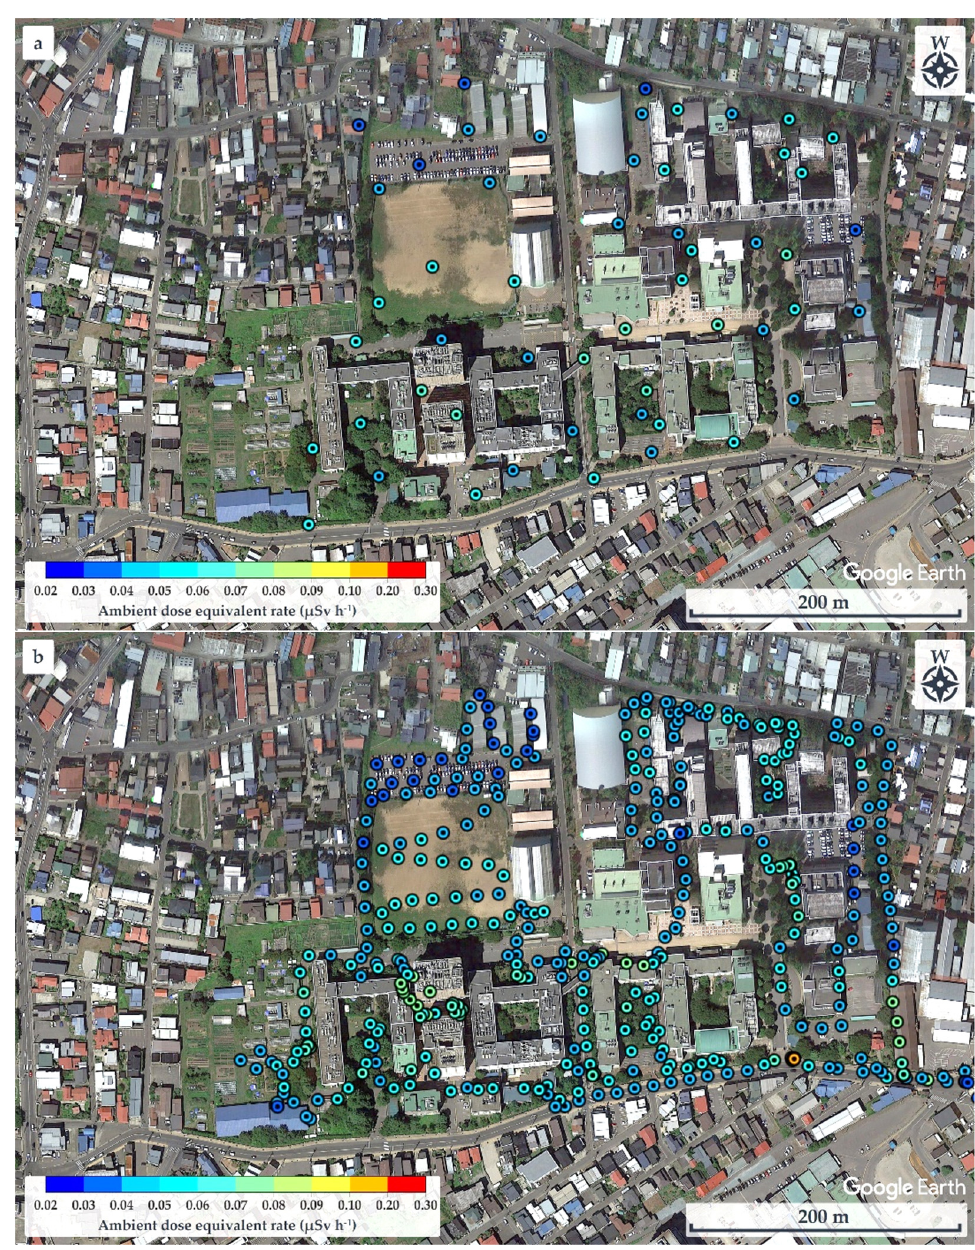
Figure 9. Dose rate distribution maps on Bunkyo campus, Hirosaki University, obtained using ( a ) spot survey technique and ( b ) walking